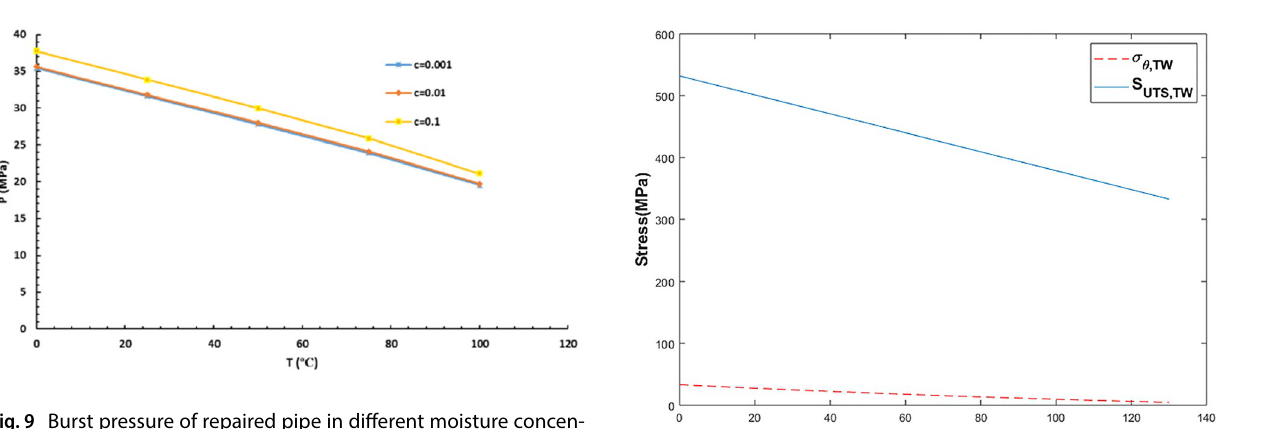
Fig. 9 Burst pressure of repaired pipe in different moisture concen- trations of composite sleeve